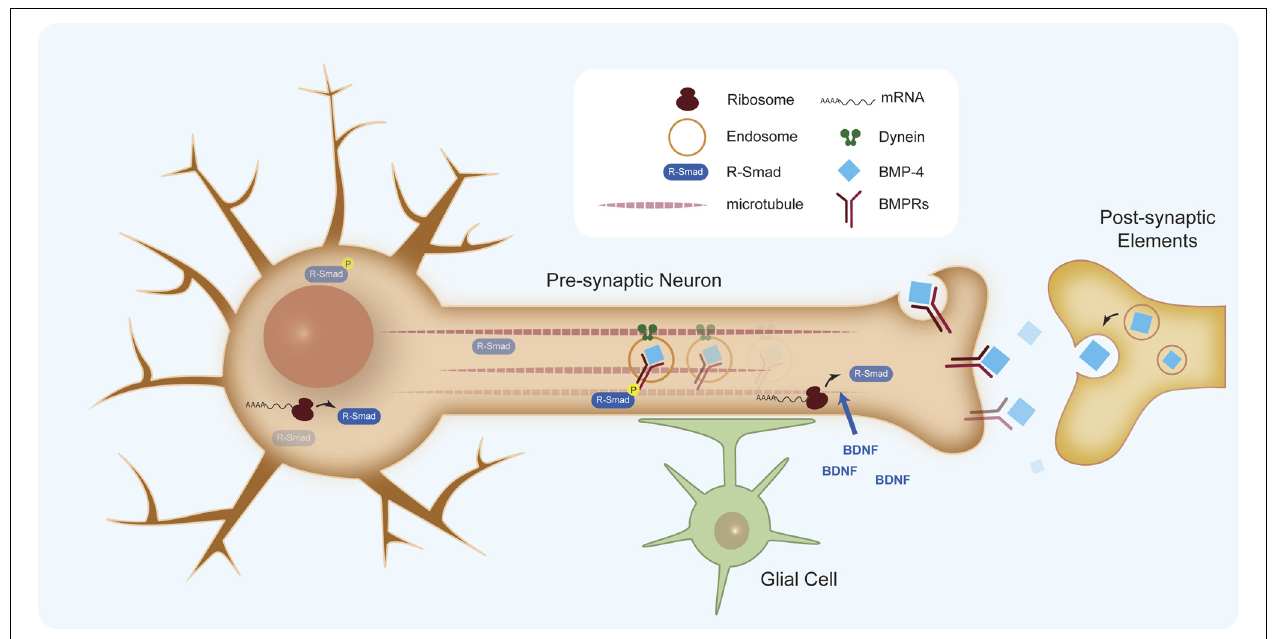
FIGURE 5 | Retrograde signaling of BMPs in synapse formation. BMP retrograde transport of endocytosed BMP receptors by dynein motors. Effective retrograde BMP signal also involves specific translation of Smad protein in the